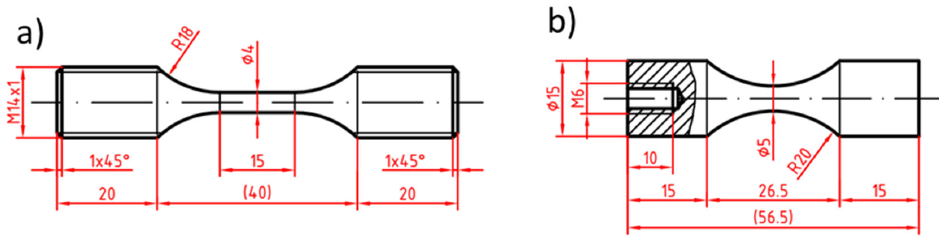
Figure 2. The geometry of fatigue tests specimens; ( a ) low and high cycle fatigue tests; ( b ) very high cycle fatigue VHCF tests. Dimensions are in mm.